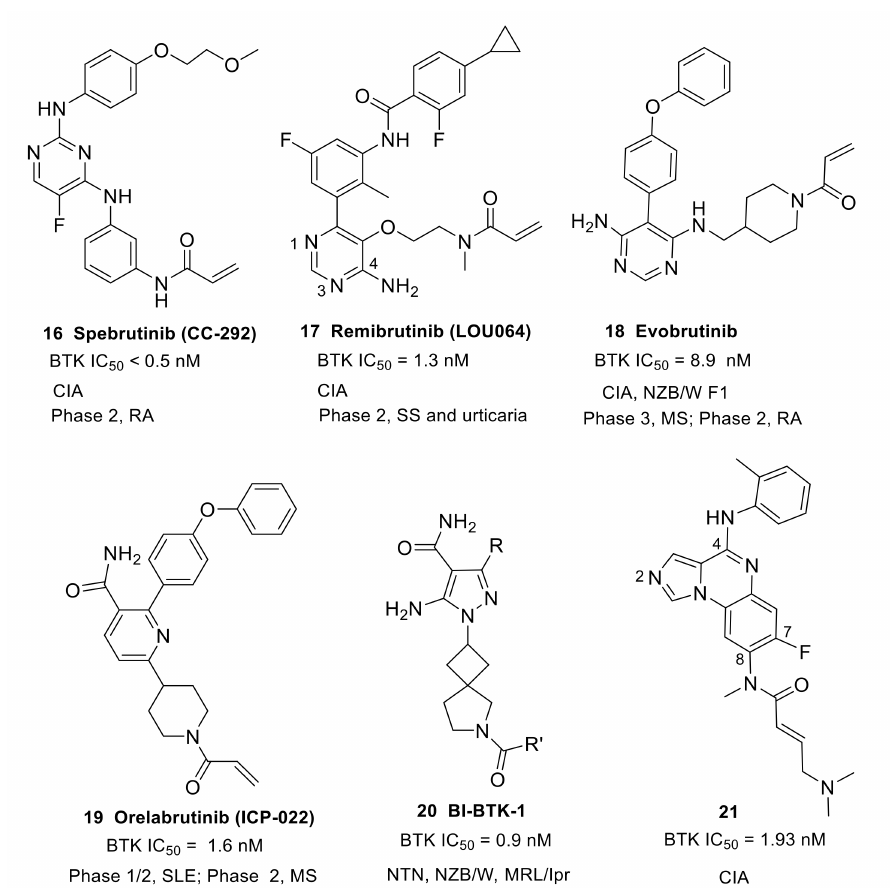
Figure 7. The representative structures of covalent irreversible BTK inhibitors with monoheterocycle and fused tricyclic heterocycle scaffolds and their progress in the treatment of autoimmune and inflammatory diseases. NTN, nephrotoxic